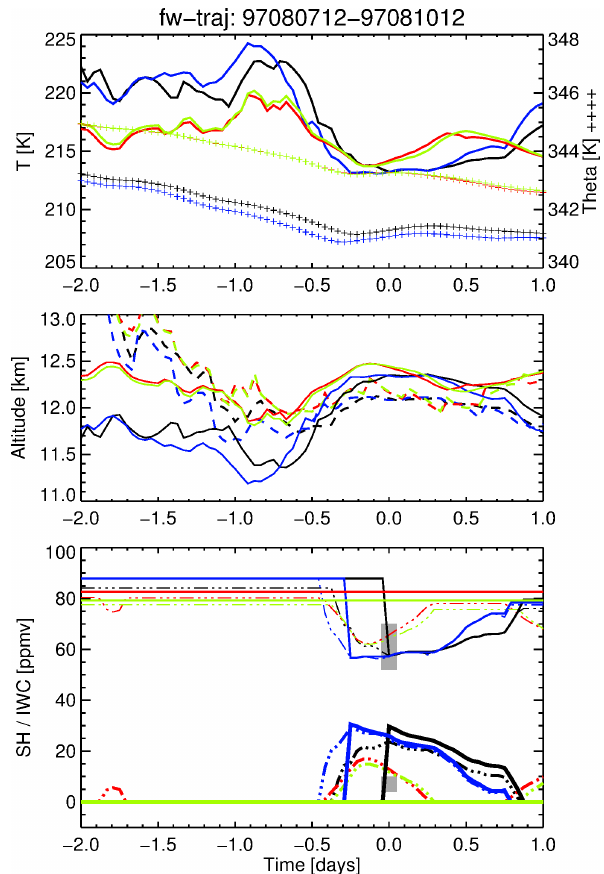
Figure 12. Forward trajectory calculations with respect to the refer- ence time of 9 August at 12:00 UTC ( − 2 days to + 1 day) with 1h temporal resolution and colour coded in the same way as the dia- mond symbols in Fig. 11 for the geographical location at reference time. Top: the panel shows temperature and potential temperature (crosses) versus time for the four trajectories shown in Fig. 11; mid- dle: altitude (solid) and superimposed tropopause height (dashed line) based on ERA Interim at the location of the trajectory; bot- tom: specific humidity (thin lines) and ice water content (thick lines below 40ppmv) as simulated with the CLaMS cirrus module. In ad- dition, specific humidity (SH) and IWC for the conventional freeze- out at 100% saturation (dash-dotted lines) are superimposed. Grey shaded areas indicate IWC and SH range in the original 24h time step CLaMS model run at the reference